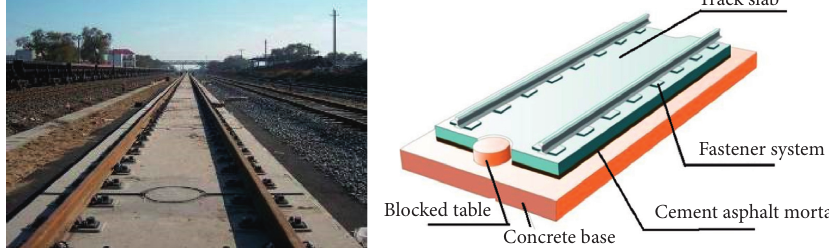
Figure 2: Structural composition of the slab track.